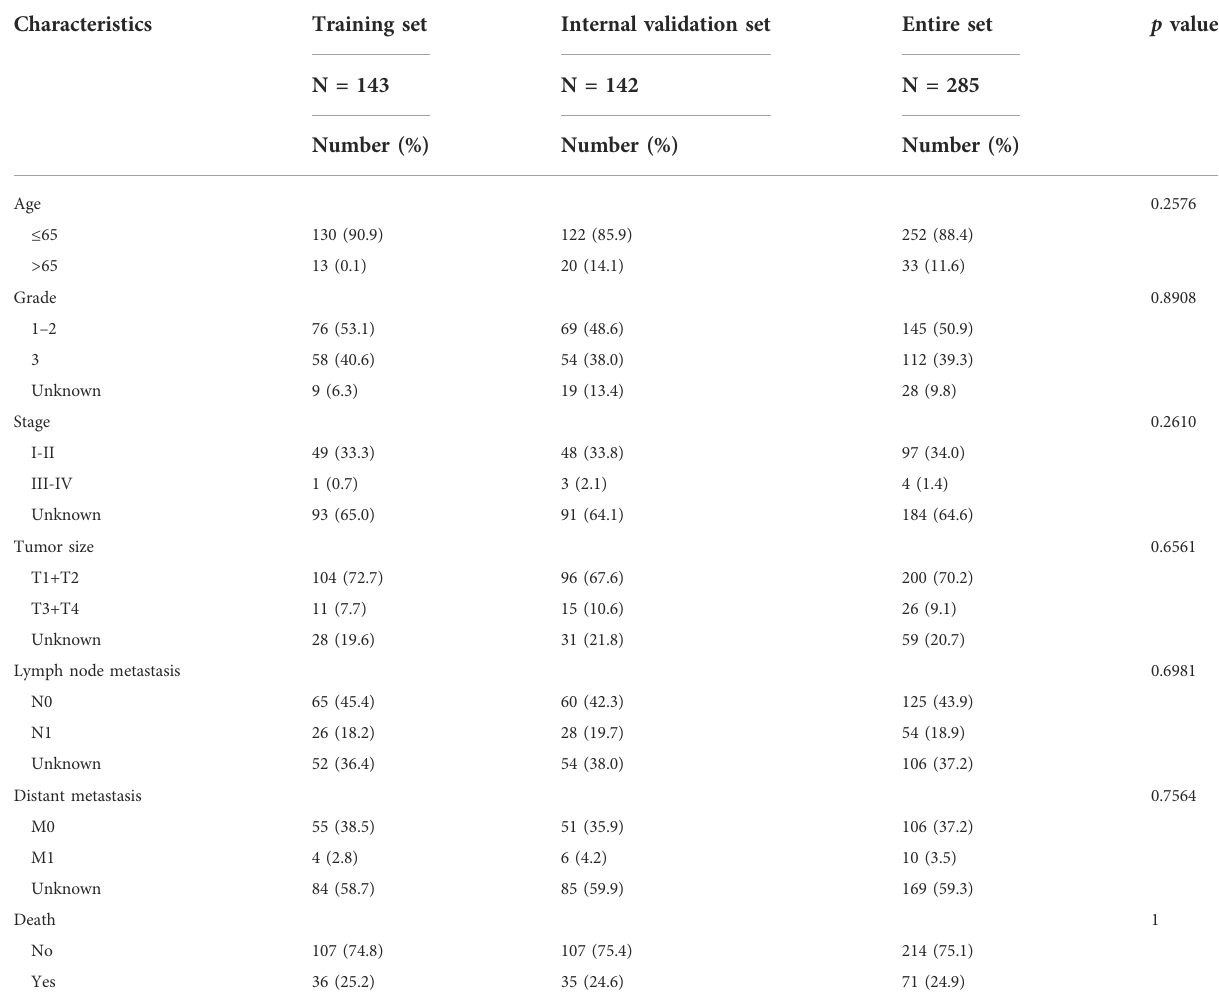
TABLE 1 Characteristics of training set, internal validation set, and entire set.